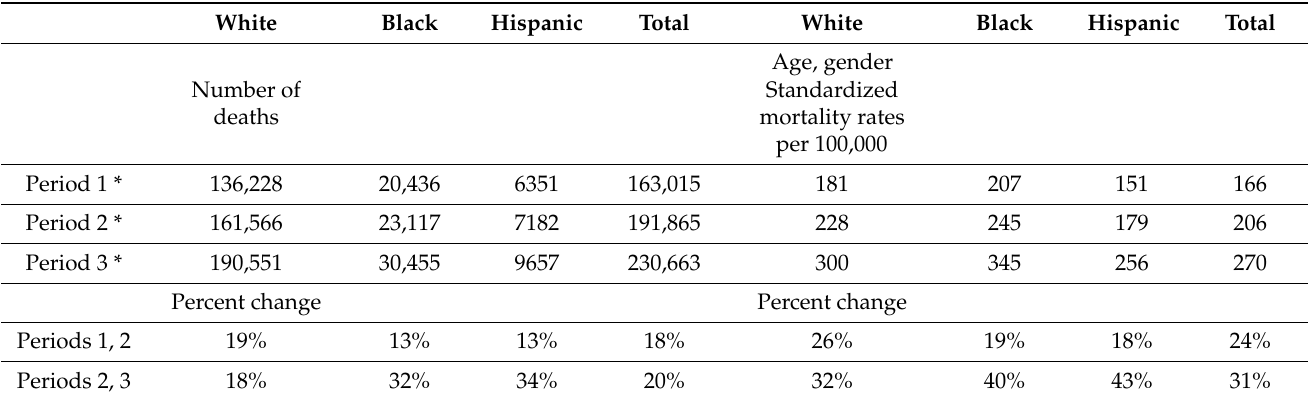
Table 1. Number of deaths and percent change in deaths during by period among VA users over 45 years old by racial/ethnic group between March 2018 and February 2021.